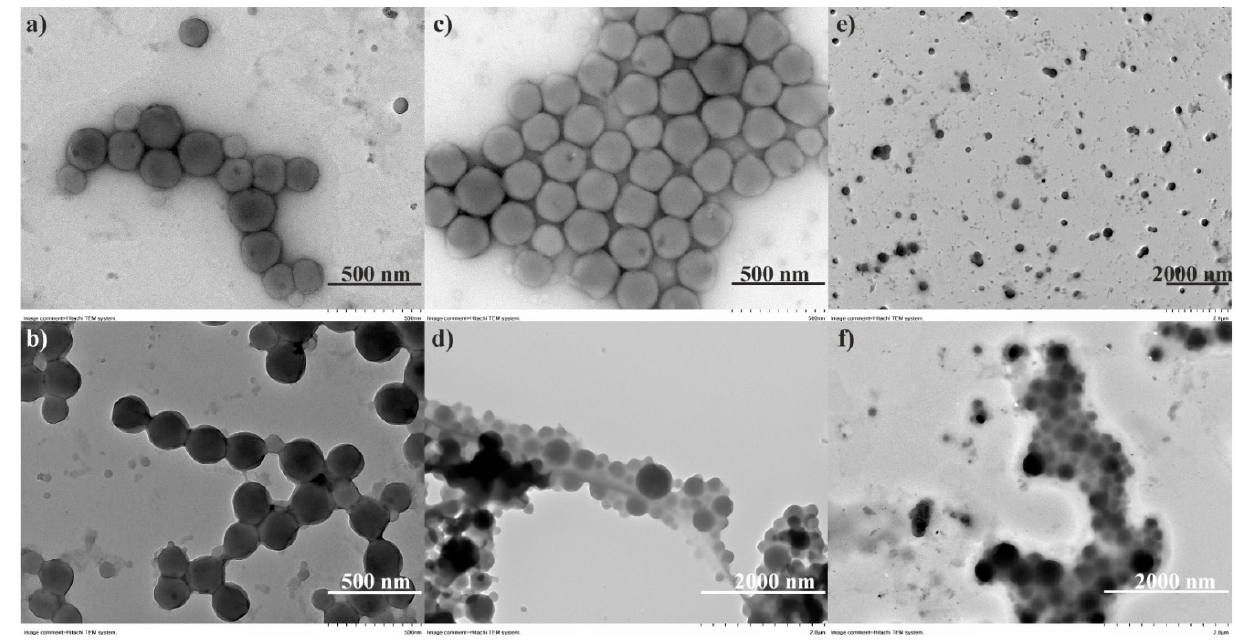
Figure 6. TEM images of: ( a ) mixed SLN of 4 (C = 1 × 10 − 4 M) and DTAC at 1:1 ratio; ( b ) mixed SLN of 4 (C = 3 × 10 − 4 M) and DTAC at 1:1 ratio; ( c ) mixed SLN of 5 (C = 1 × 10 − 4 M) and DTAC at 1:1 ratio; ( d ) mixed SLN of 5 (C = 1 × 10 − 4 M) and DTAC at 1:1000 ratio; ( e ) mixed SLN of 6 (C = 1 × 10 − 4 M) and DTAC at 1:1 ratio; ( f ) mixed SLN of 6 (C = 1 × 10 − 4 M) and DTAC at 1:100 ratio.